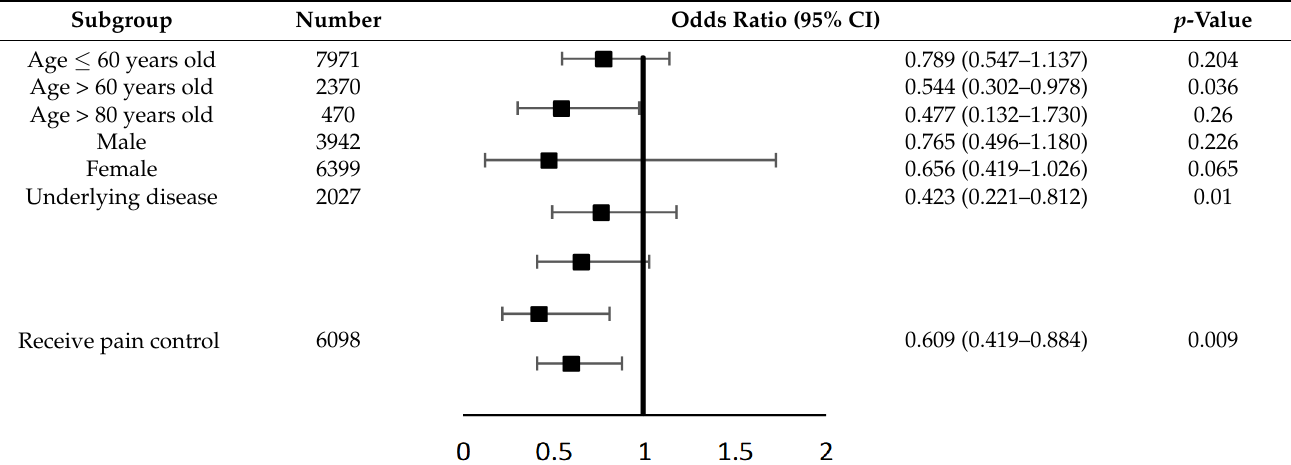
Table 3. Subgroup analysis of hazard ratio of CT scan from index visit to return ED visit.